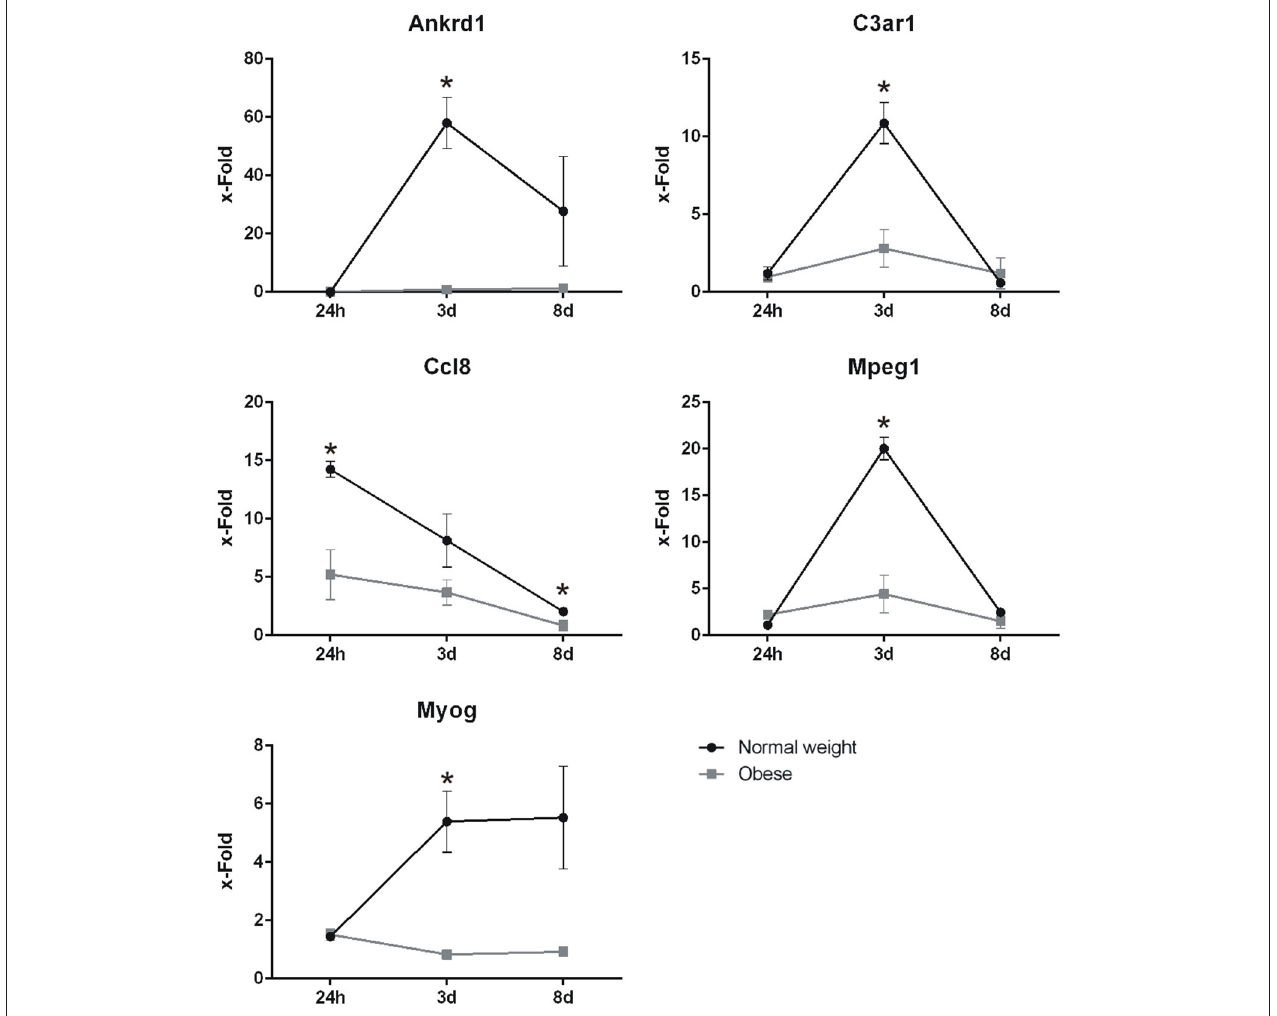
FIGURE 9 | Expression levels of Ankrd1 , C3ar1 , Ccl8 , Mpeg1 , and Myog determined by qPCR on Ppia as housekeeper. X-fold values ± SEM were determined by normalization on corresponding controls of each time point and diet. Statistical analysis by two-sided homoscedastic t -test. *Indicates p ≤ 0.05, n =